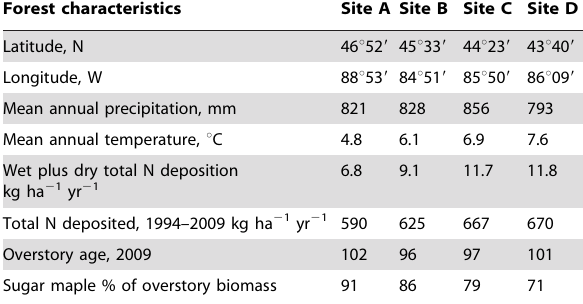
Table 1. Site, climatic, overstory and ambient nitrogen deposition rates of four sugar maple stands receiving experimental NO 3-